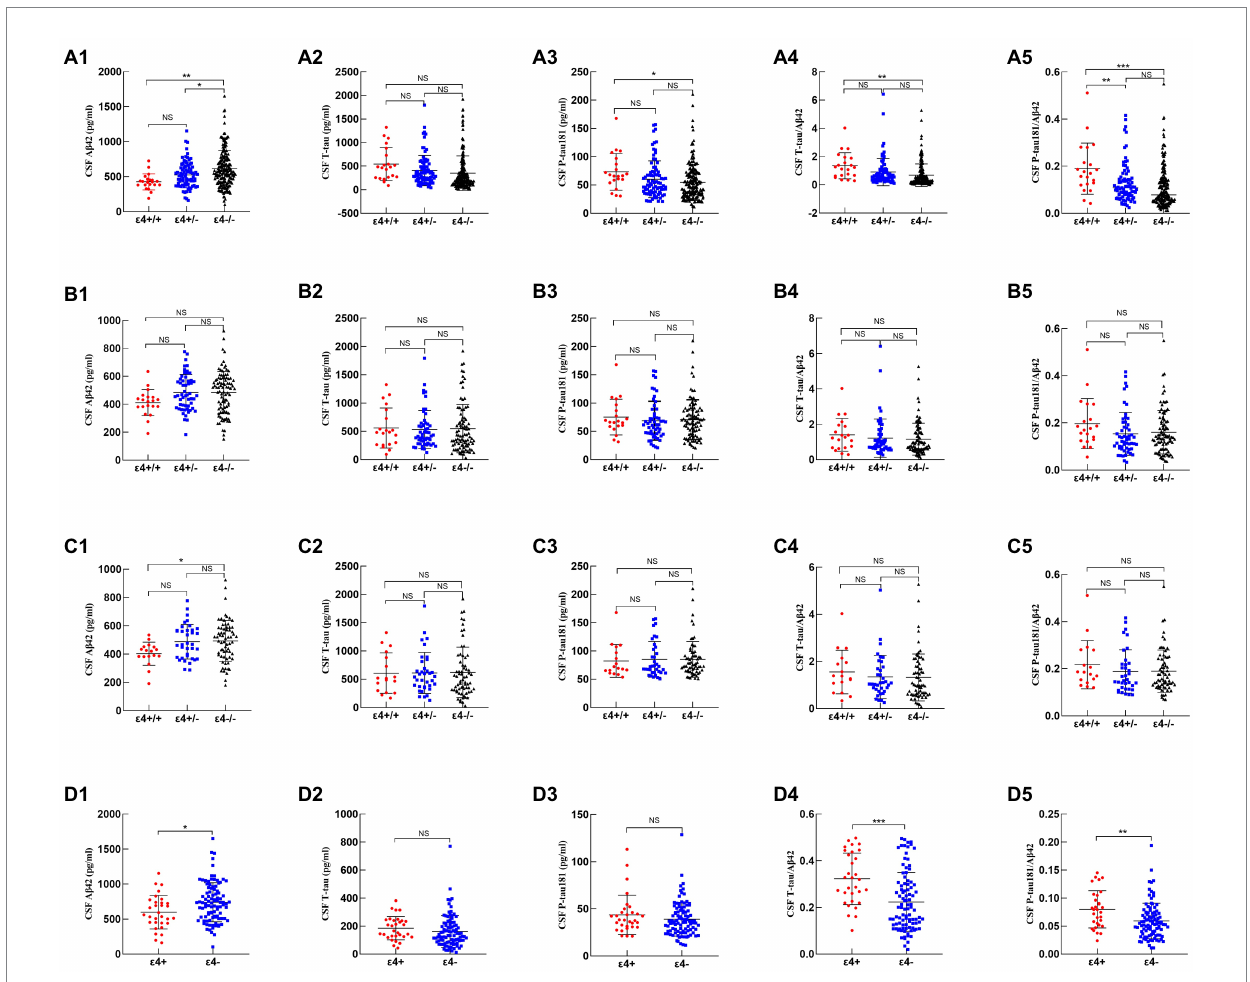
FIGURE 1 Comparison of CSF biomarkers among APOE genotypes. 1–5 represented CSF A β 42, T-tau, P-tau181, T-tau/A β 42, and P-tau181/A β 42, respectively. (a1–a5), (b1–b5), (c1–c5), and (d1–d5) represented CSF biomarkers of all subjects, such as Alzheimer’s continuum, AD, and non-AD, respectively. p -values were calculated and were shown above the boxes as stars (*** p < 0.001, ** p- value < 0.01, * p -value < 0.05, “NS”, and not significant p >